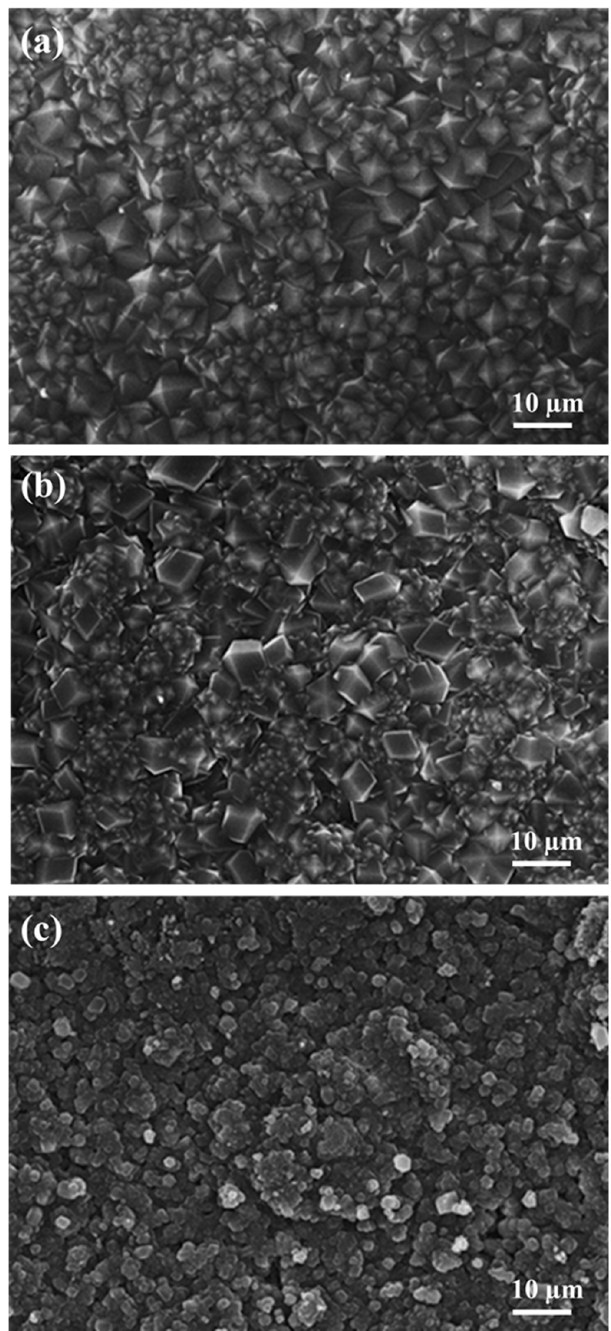
Figure 7. SEM top-view image of Co44-ZIF-8 membrane with different amounts of mIM: ( a ) 4 mmol, ( b ) 8 mmol, and ( c ) 16 mmol.